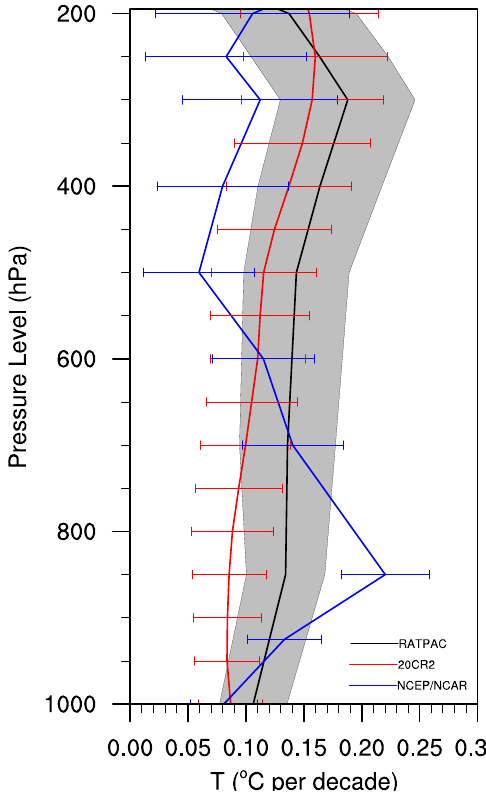
Fig. 1. Comparison of the vertical structures of the annual-mean temperature trends ( ◦ C per decade) in the 20CR2, NCEP/NCAR and observations (RATPAC) for 1958–2010. Also shown are the 95% confidence intervals (grey band for observations and error bars for the 20CR2 and